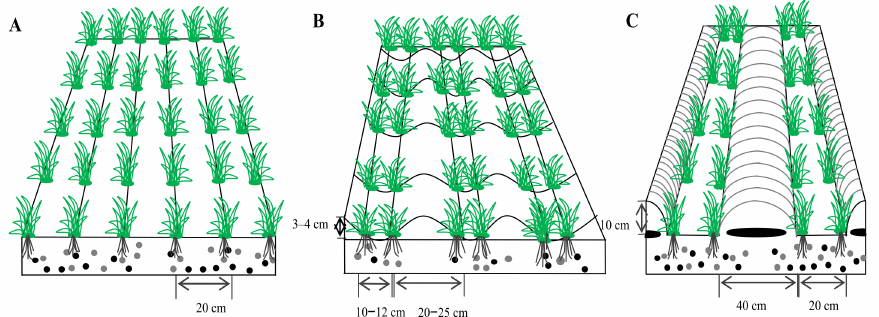
Figure 1. A schematic diagram of the three planting patterns. ( A ) DS, drilling sowing. ( B ) FS, furrow sowing. ( C ) FM, film-mulched sowing. Ridge covered with plastic film mulch. The point in black and grey indicate